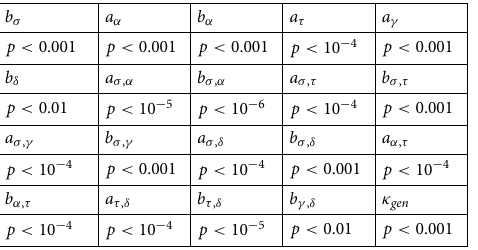
Table 3. Significant MsCr measures in mild cognitive impairment (MCI).